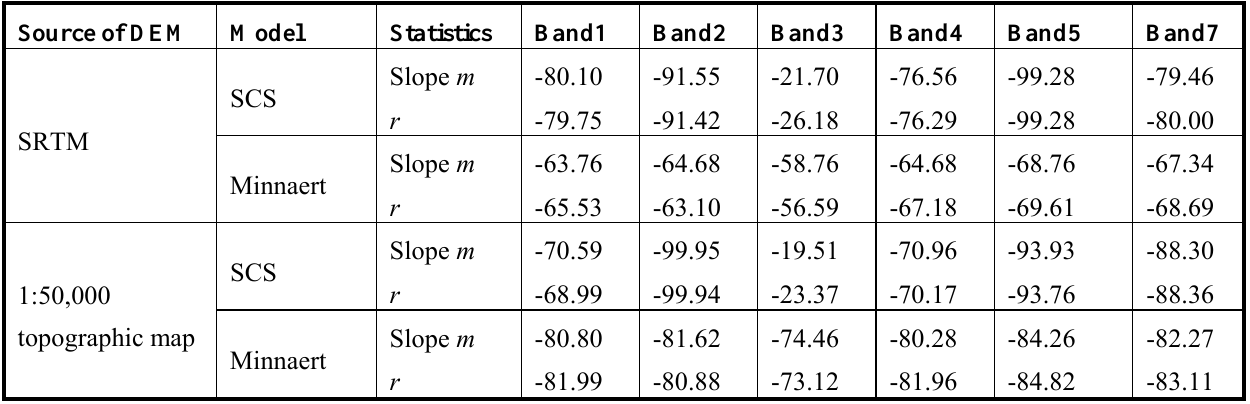
Table 4. Relative correction extent for slope m and correlation coefficient r (unit: %).